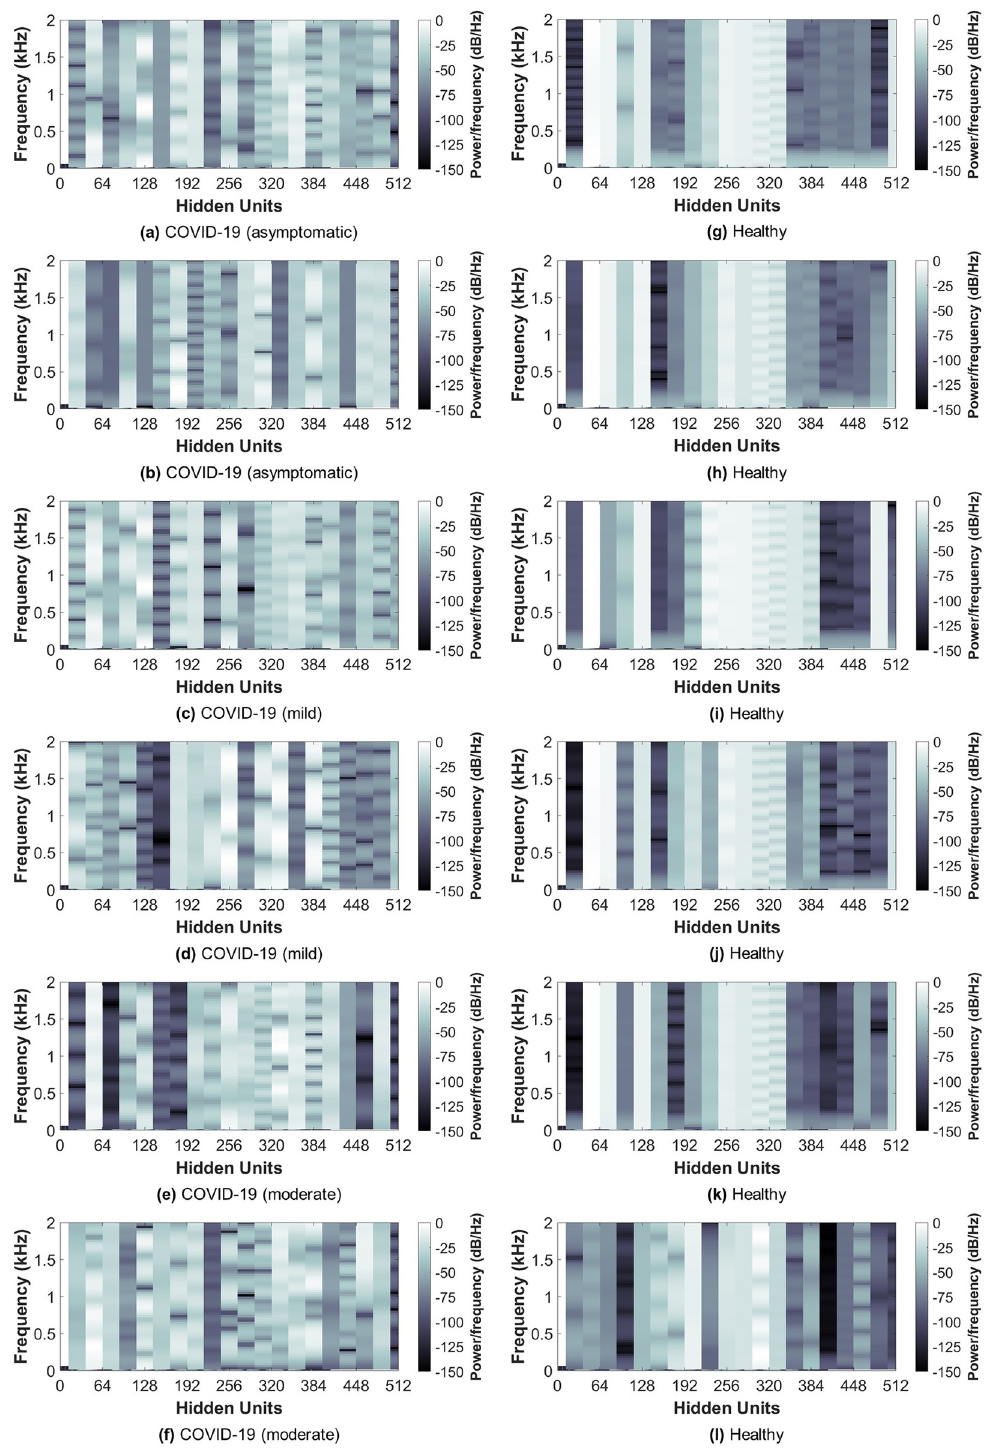
Fig 9. Bi-directional long short-term memory (BiLSTM) network activations extracted for five examples from COVID-19 and healthy subjects using shallow breathing recordings. The activations were extracted from the last layer (applied on the flattened convolutional neural network (CNN) features vector) of the deep learning network (BiLSTM) for five examples from COVID-19 (a-f) and healthy (g-l) subjects.